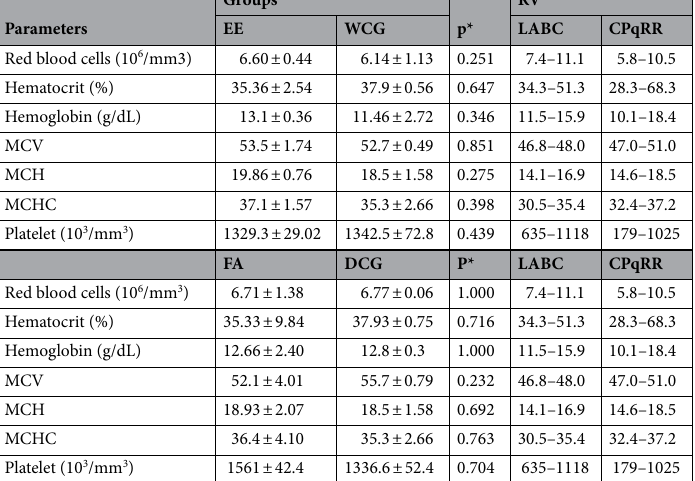
Table 2. Erythrogram and platelet count of mice treated with ethanolic extract or alkaloid fraction from Aspidosperma nitidum. EE ethanolic extract, FA fraction of alkaloids, WCG water control group, DCG DMSO control group (99% water + 1% DMSO), RV reference value, LABC Laboratory Animal Breeding Center, CPqRR René Rachou Research Center. * p value was obtained by Student’s T-test, comparing EE versus WCG, or FA versus